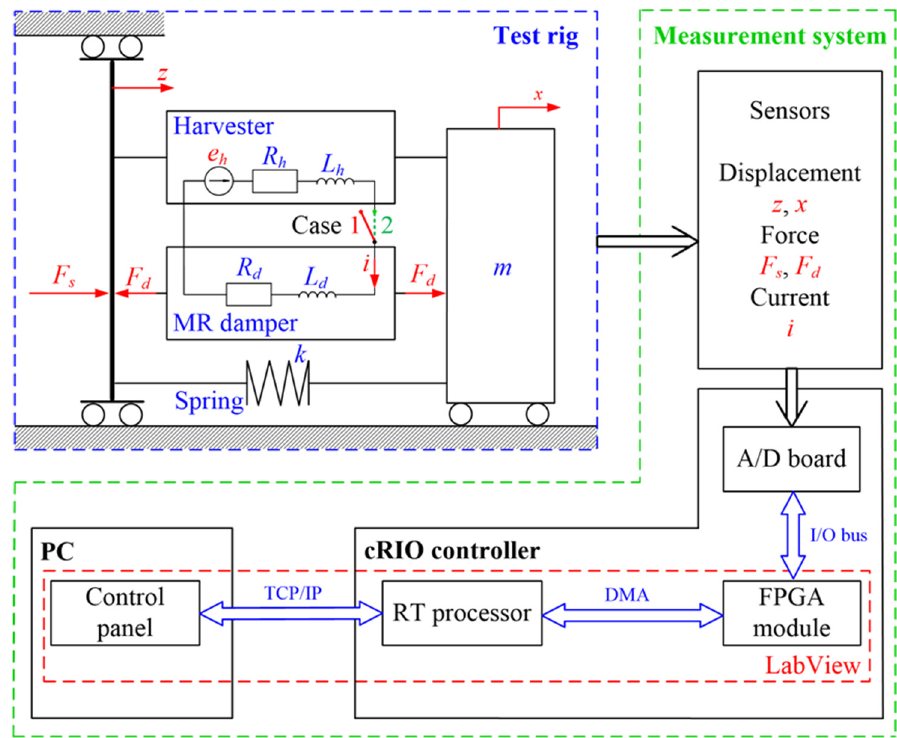
Figure 3. Test rig and measurement system layout.